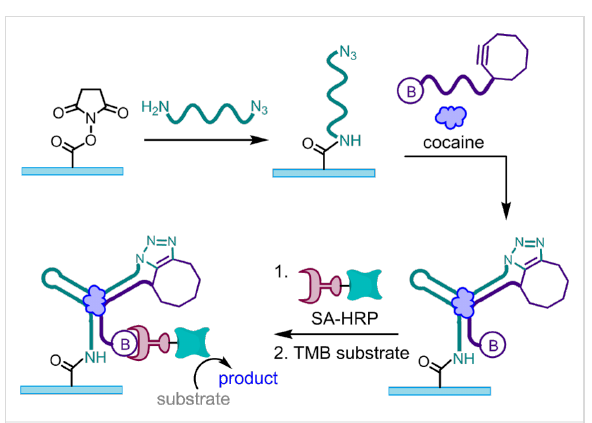
Figure 3: Split aptamer ligation can be used to construct an enzyme- linked assay for small-molecule detection. Conversion of the small molecule signal into a dose-dependent covalent ligation event allows signal to be produced even if target binding is lost. Reprinted with permission from [13]. Copyright (2012) American Chemical Society.